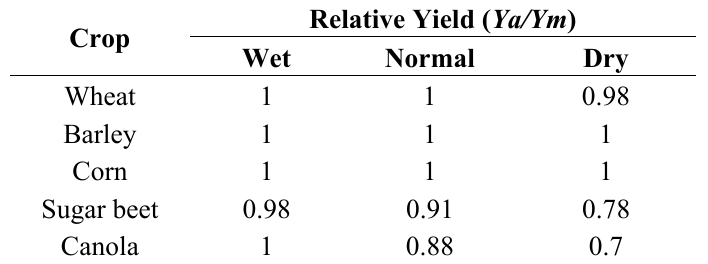
Table 3. Relative yield ( Y a / Y m ) of crops under study corresponding to various weather conditions. Relative Yield ( Ya/Ym ) Crop Wet